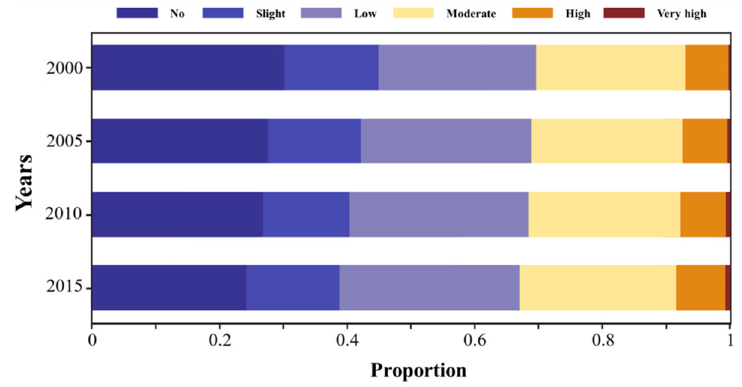
Figure 4. The proportion of different human pressure classes in 2000, 2005, 2010, and 2015.